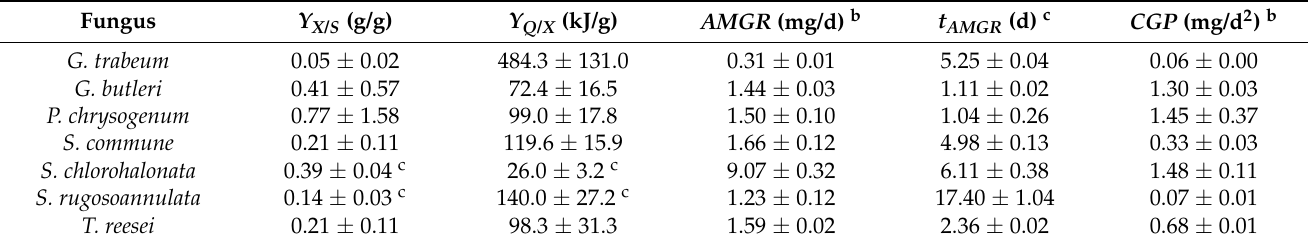
Table 2. The observed biomass yield coefficients ( Y X/S ) , metabolic heat yield coefficients ( Y Q/X ), apparent maximum growth rates ( AMGR ), and cultivation times until growth at maximal rate, respectively ( t AMGR ); the competitive growth potential values ( CGP ) of fungal wheat straw cultures during the 32 ( S. chlorohalonata and S. rugosoannulata ) or 20 days of cultivation (all other fungi) a . Y X/S (g/g) Y Q/X (kJ/g) AMGR (mg/d) b t AMGR (d) c CGP (mg/d 2 )